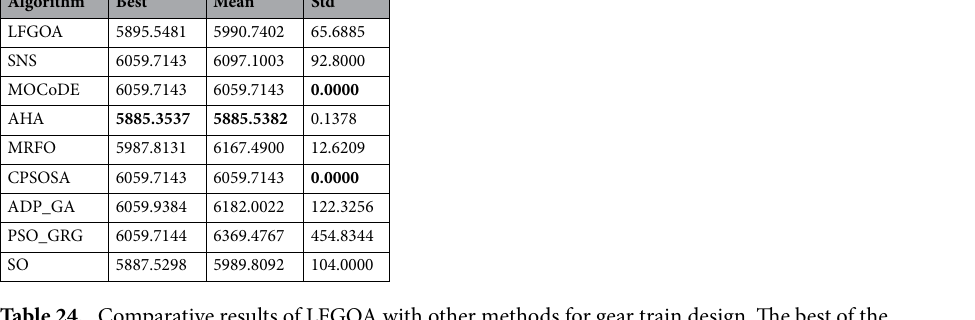
Table 24. Comparative results of LFGOA with other methods for gear train design. The best of the comparison results are in [bold].